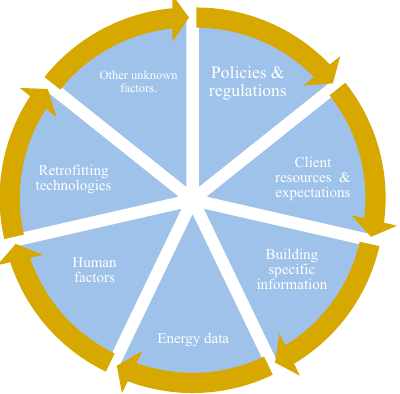
Fig. 1. Key elements affecting the retro fi tting of buildings.